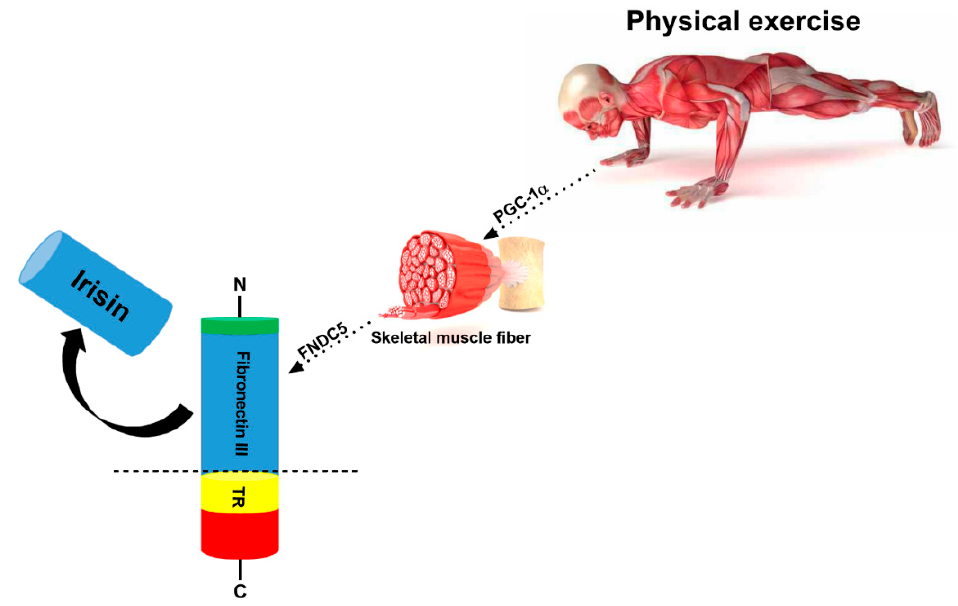
Figure 2. Irisin is produced by exercise. In response to exercise peroxisome proliferator, PGC-1 α , leads to the production of FNDC5, a protein which contains an N-terminal signal sequence (green); fibronectin III (blue); a transmembrane region (TR) (yellow); a cytosolic region with a C-terminal tail (red). The proteolytic cleavage of mature FNDC5 results in the release of irisin, which corresponds to the fibronectin III domain with the signal sequence being removed.